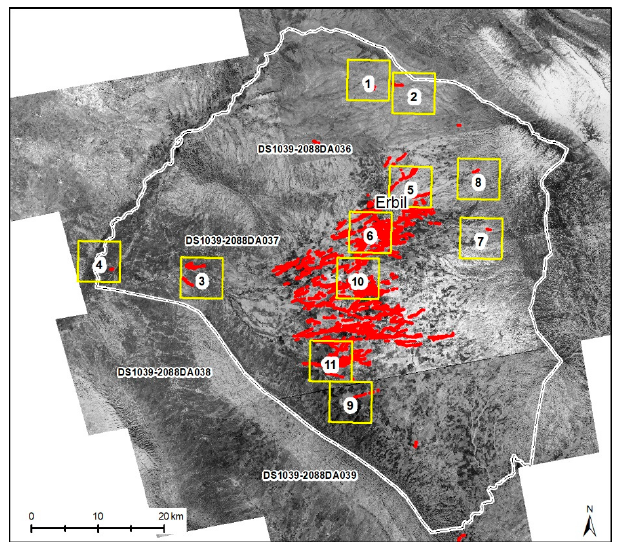
Figure 9. Approximate location of the 11 training patches.